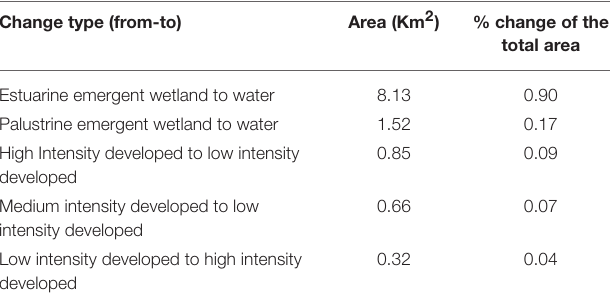
TABLE 3 | Land-cover change between 2005 and 2006 in New Orleans. TABLE 5 | Land-cover change between 2001 and 2010 in New